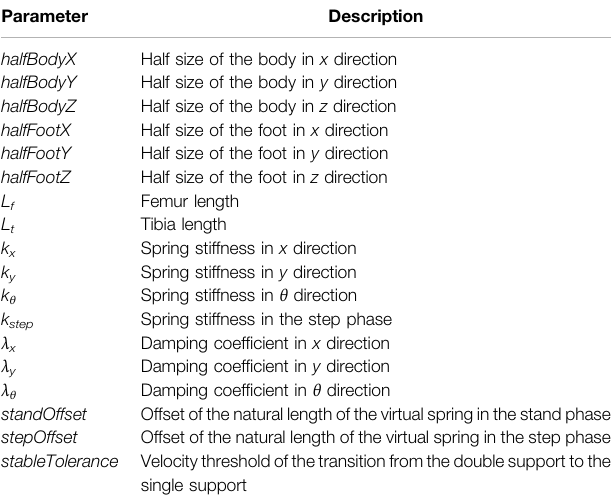
TABLE 1 | Virtual Model